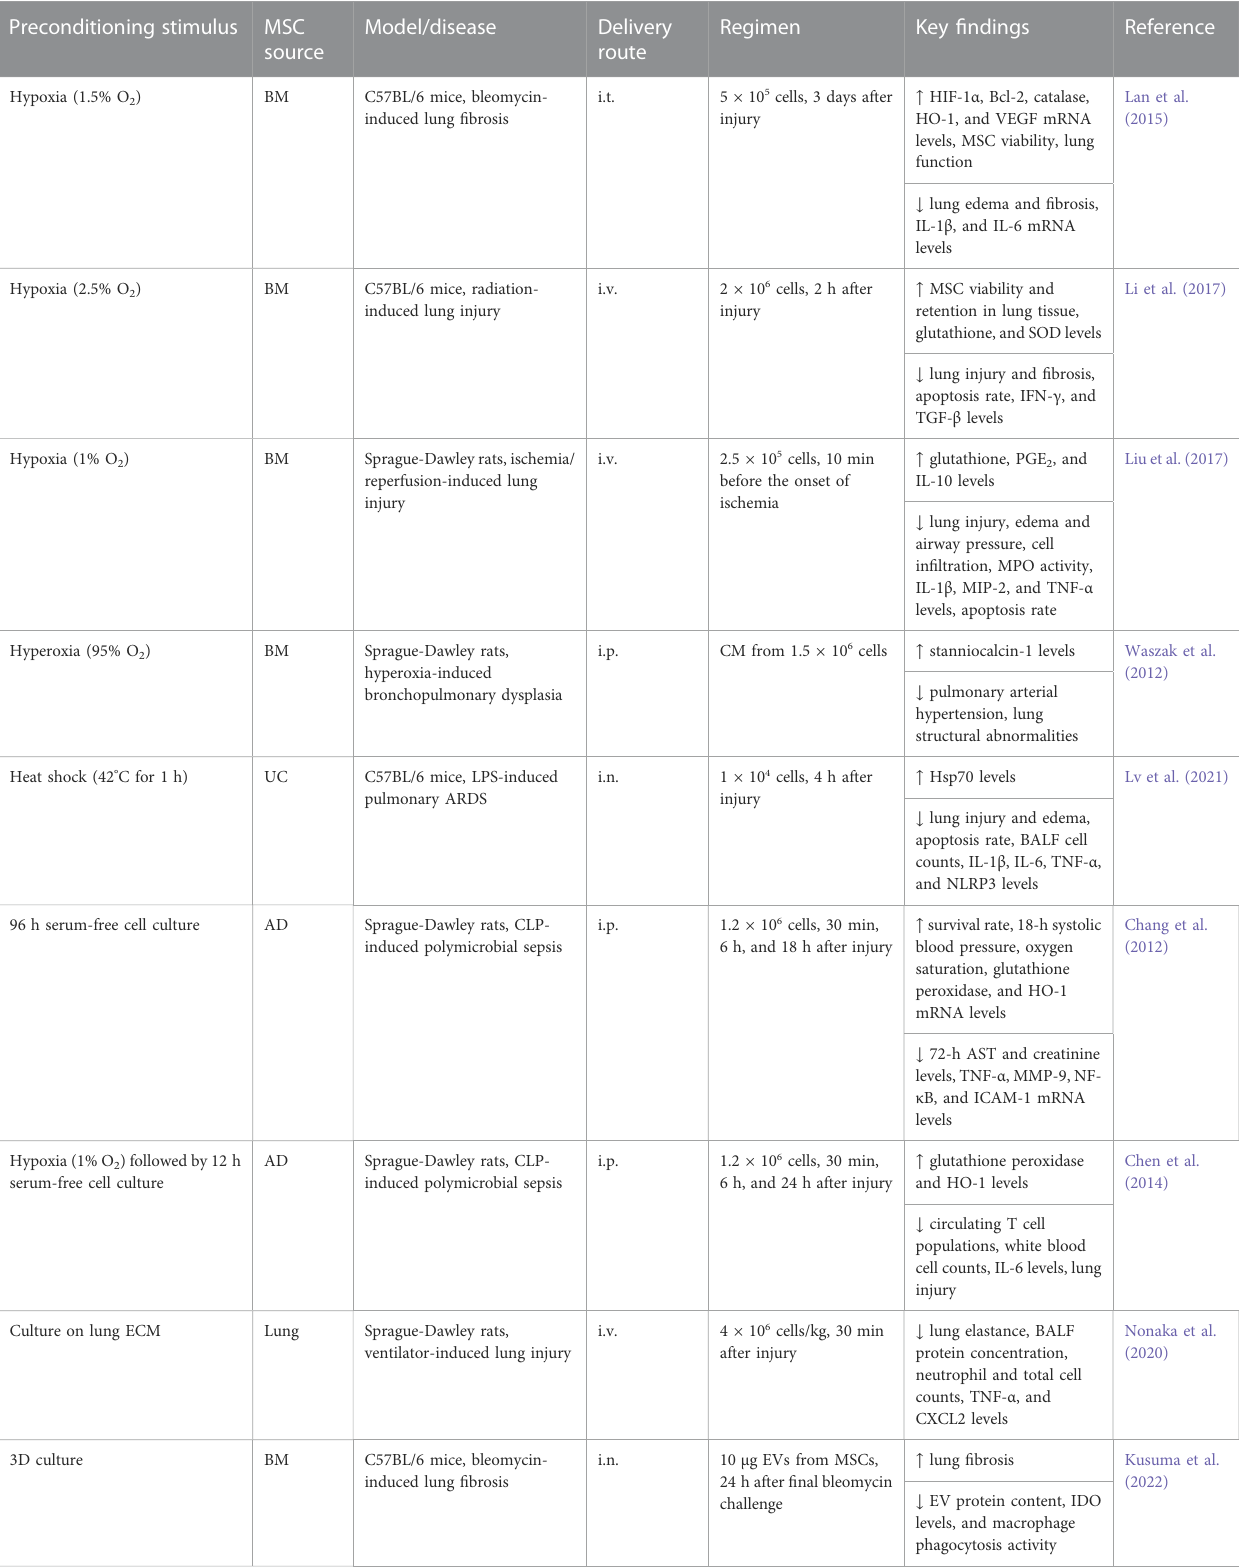
TABLE 1 In vivo preclinical studies assessing the ef fi cacy of MSC preconditioning by altering the culture conditions. Preconditioning